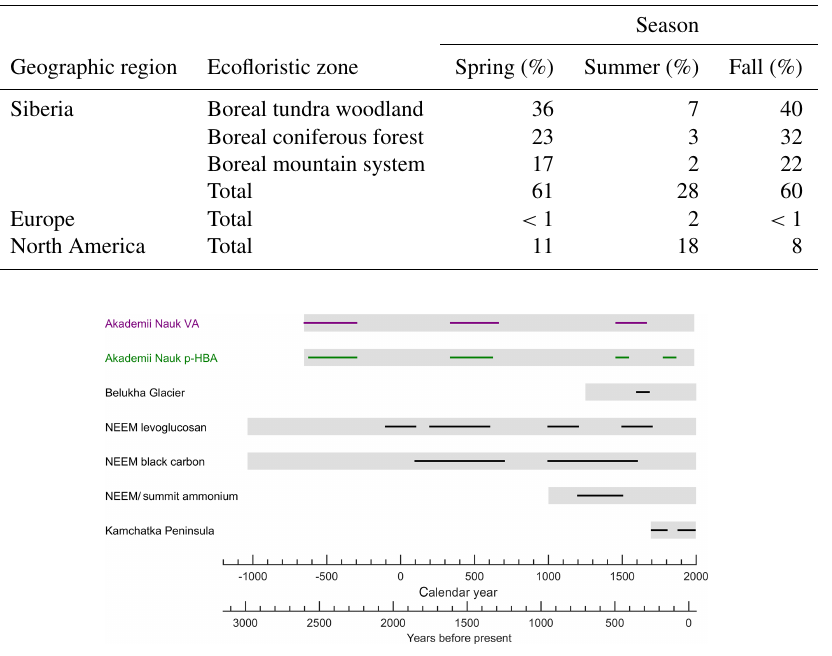
Table 1. Fractions of air mass back trajectories originating from or intersecting various ecofloristic zones and geographic regions (% rounded to the nearest integer). Ecofloristic zones are defined by the Food and Agriculture Organization (Fig. S7; http://cdiac.ornl.gov/epubs/ndp/ global_carbon/carbon_documentation.html; Ruesch and Gibbs, 2008).